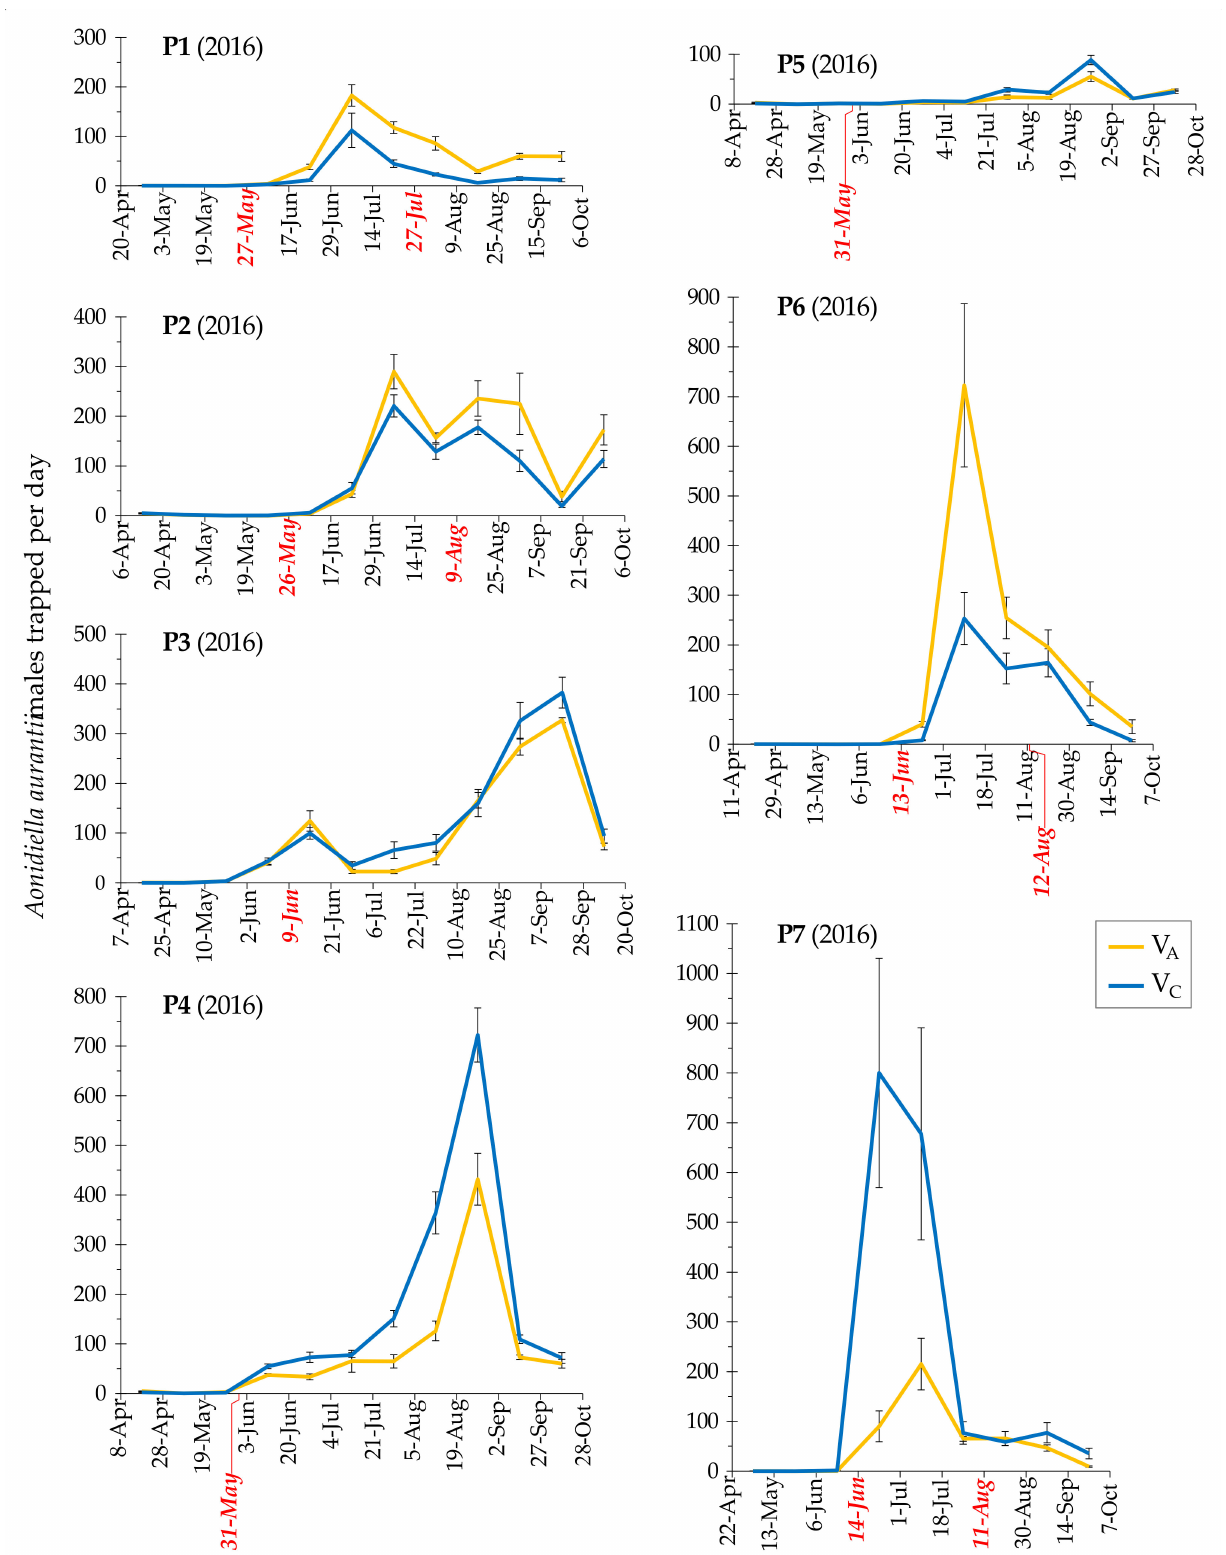
Figure 5. Number of Aonidiella aurantii males trapped on sticky traps per day (mean value with standard error bar) for each treatment (V A : adjusted volume, V C : conventional volume) and for the seven plots (P1–P7) between April and October 2016. The x-axis shows the dates the traps were placed/removed. Dates in red indicate spray applications against A. aurantii